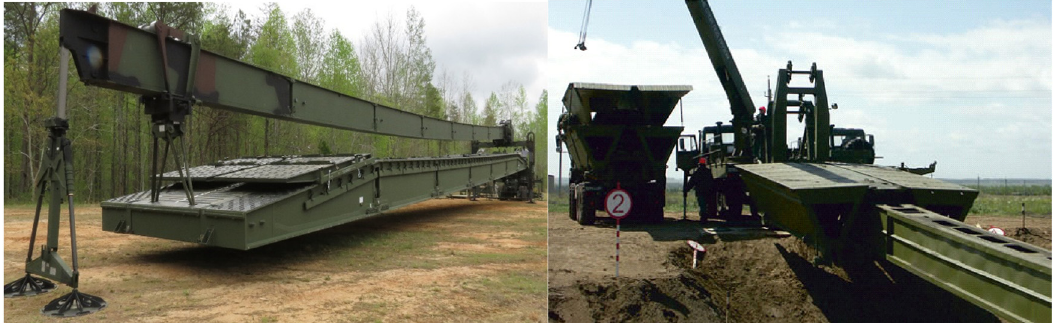
Figure 5: Di ff erent types of launching beams, DSB ( on the left ) and MMK ( on the right ) [ 2 ] .